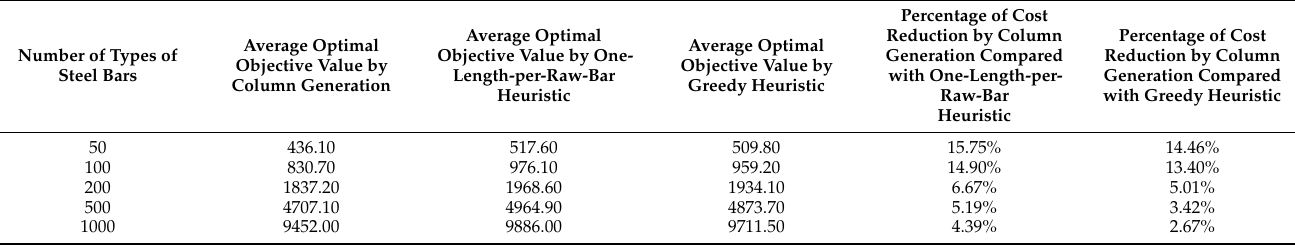
Table 8. Comparison results the three